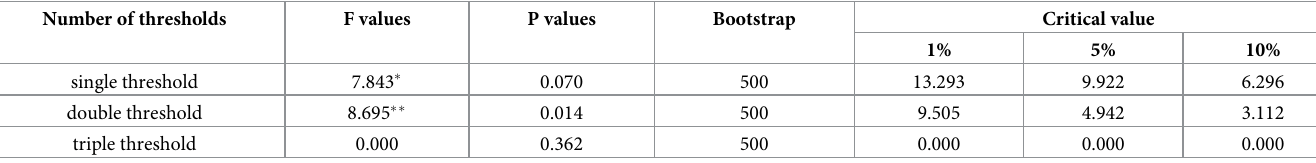
After analyzing the derived thresholds, this paper estimated the parameters of the double- threshold model, and the results are shown in Table 8. For the control variables, the effects of human capital level, population density and regional economic level on the efficiency of gov- ernment public service supply were not significant. In contrast, population structure, Table 6. Results of the threshold effect